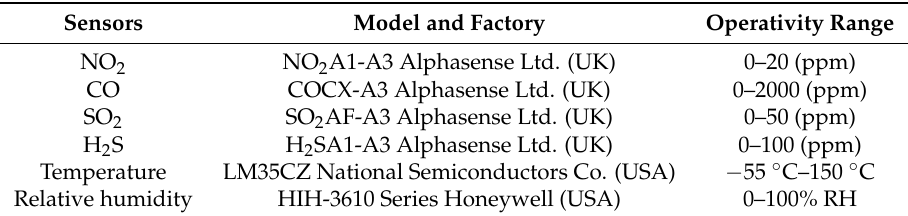
Table 3. NASUS IVmulti-sensor system: sensor